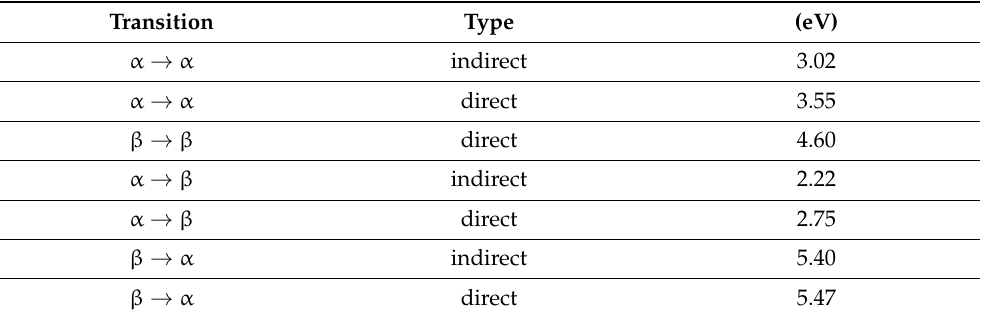
Table 3. B3LYP/6-21G spin-allowed ( ∆ s z = 0) and spin-forbidden ( ∆ s z H 0) virtual transition energies in N s0 taken from Figure 2a, where the defect (N/C*) band width is 0.53 eV and the gap to the valence band upper edge, 1.9 eV.